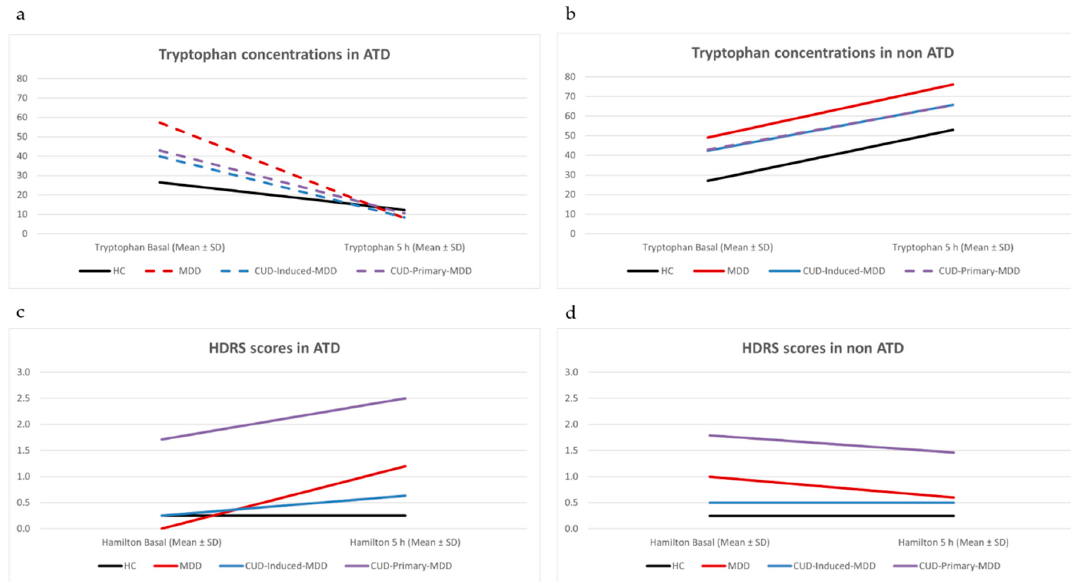
Figure 2. Variations in tryptophan concentrations and Hamilton Depression Rating Scale (HDRS) scores in both acute tryptophan depletion (ATD) and non-ATD tests. Dotted lines indicate significant changes (according to repeated measures ANOVA) between basal and 5 h follow up. 2a p < 0.020, 2b p = 0.030. ( a ) Tryptophan concentrations in ATD. ( b ) Tryptophan concentrations in non ATD. ( c ) HDRS scores in ATD. ( d ) HDRS scores in non Table 2. Basal values for the serotonin–kynurenine pathways (ng/mL for concentrations and adimensional for ratio values).